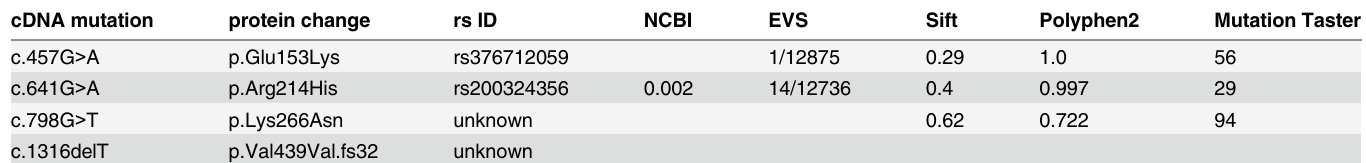
Table 1. Characteristics of the novel mutations identified in TBC1D24 gene.